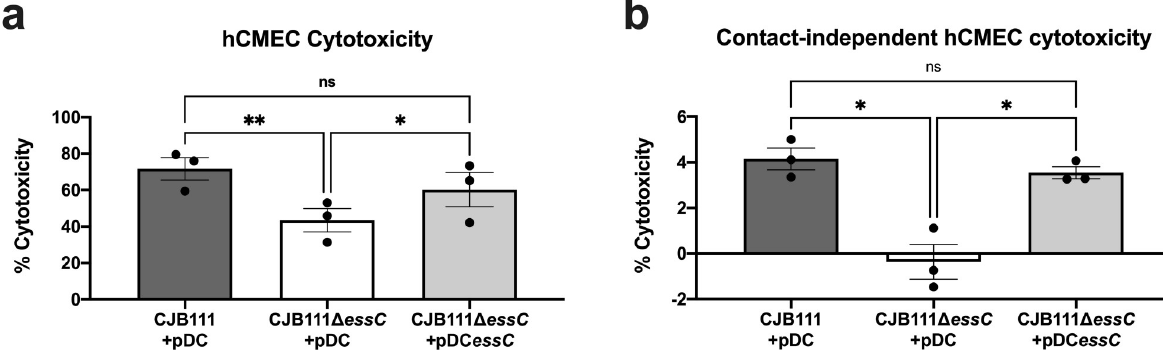
Fig 3. CJB111 T7SS elicits cell death in human cerebral microvascular endothelial cells. a) hCMEC cytotoxicity calculated based on LDH release assay. Supernatant was collected from hCMECs infected with CJB111+pDC, CJB111 Δ essC +pDC, and CJB111 Δ essC +pDC essC at MOI 10, 4–5 hours post-infection. Percent cytotoxicity was calculated based on 0% (uninfected) and 100% (+lysis buffer) lysis controls. b) Contact-independent cytotoxicity in hCMECs during GBS infection using 0.4 μ m polycarbonate transwells in which GBS and cells were separated by the porous membrane. Cytotoxicity was measured 24 hours later. Supernatant from hCMEC compartments were plated after the experiment to ensure no bacterial contamination. Statistics reflect the repeated-measures one way ANOVA with Tukey’s multiple comparisons, p < 0.05, � ; p < 0.01, �� . Data represent the mean of three independent experiments and error bars represent standard error of the mean.